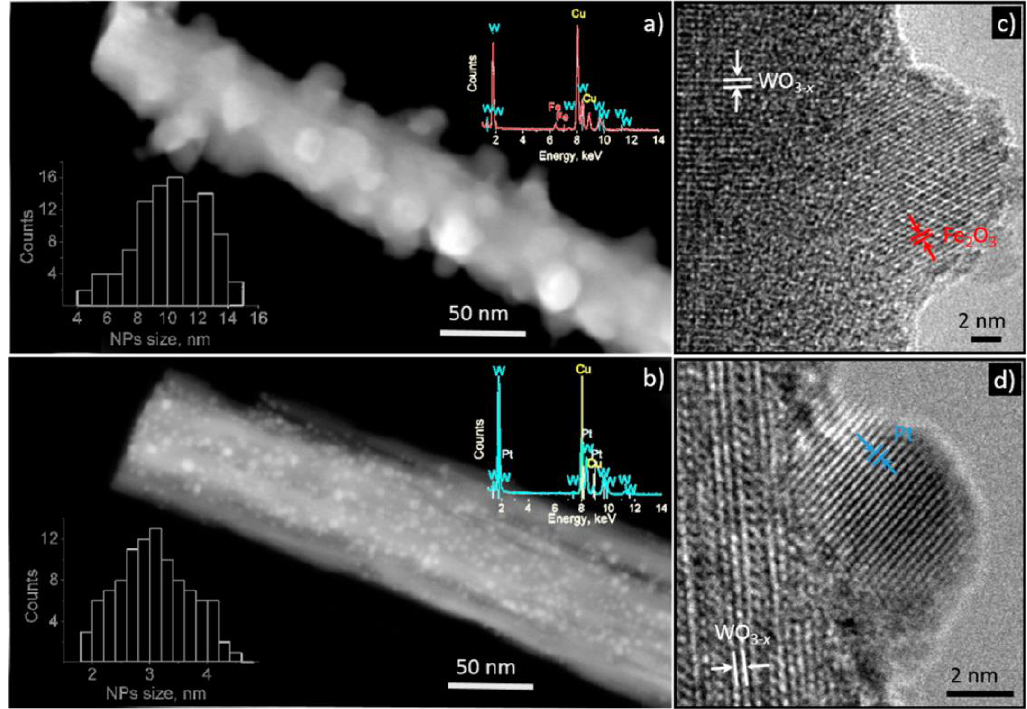
Figure 3. STEM and HRTEM of the WO 3 − x nanoneedles functionalized with Fe 2 O 3 . The figure is reprinted with permission from [27]. Copyright 2015 American Chemical Society.